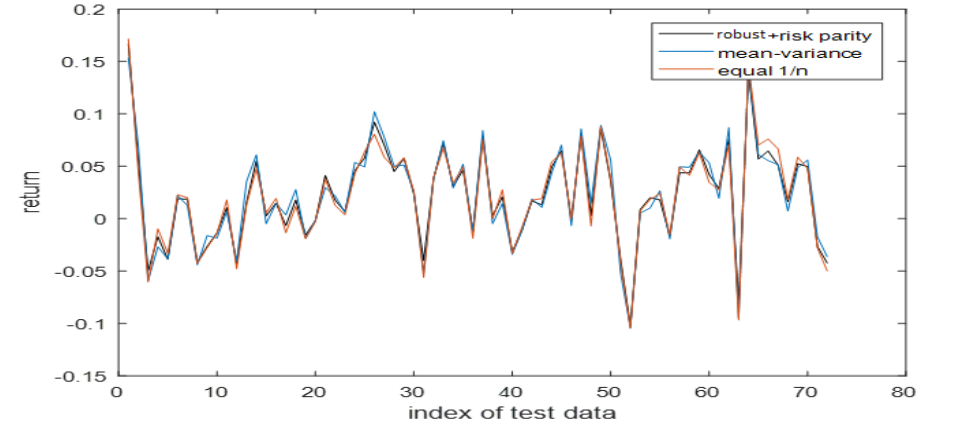
Figure 4. Performance of three portfolios on test